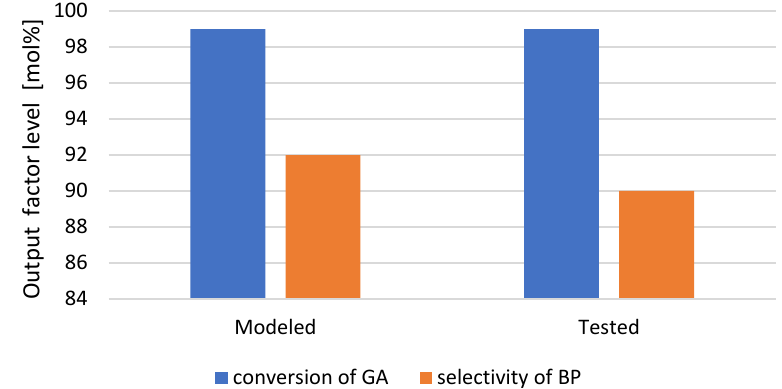
Figure 13. Comparison of modelled and tested output parameters of optimization.